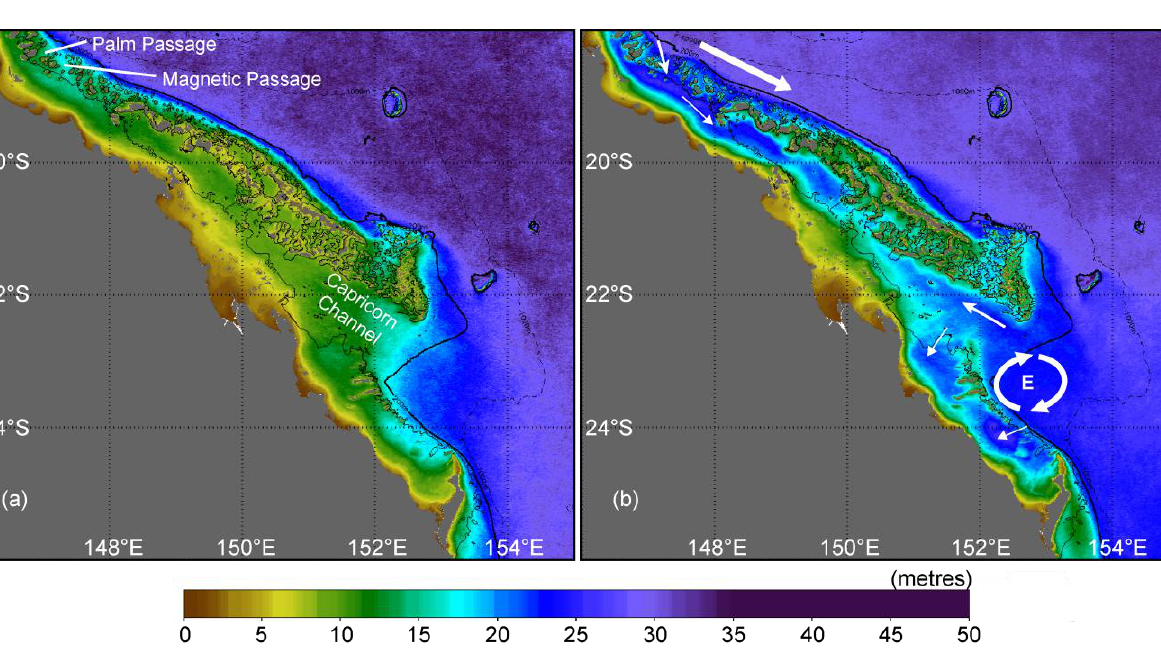
Figure 3. Long-term (2002–2012) monthly mean Secchi depth (m) on the central-southern Great Barrier Reef showing waters most turbid ( a ) during March and most transparent ( b ) during September. The solid black line denotes the 200 m isobath. The large white arrow represents the southward flow of the East Australian Current, with smaller white arrows showing the directions of oceanic intrusions onto the shelf. The circular arrows show the location of the Capricorn Eddy (E) that forms in the lee of the shelf